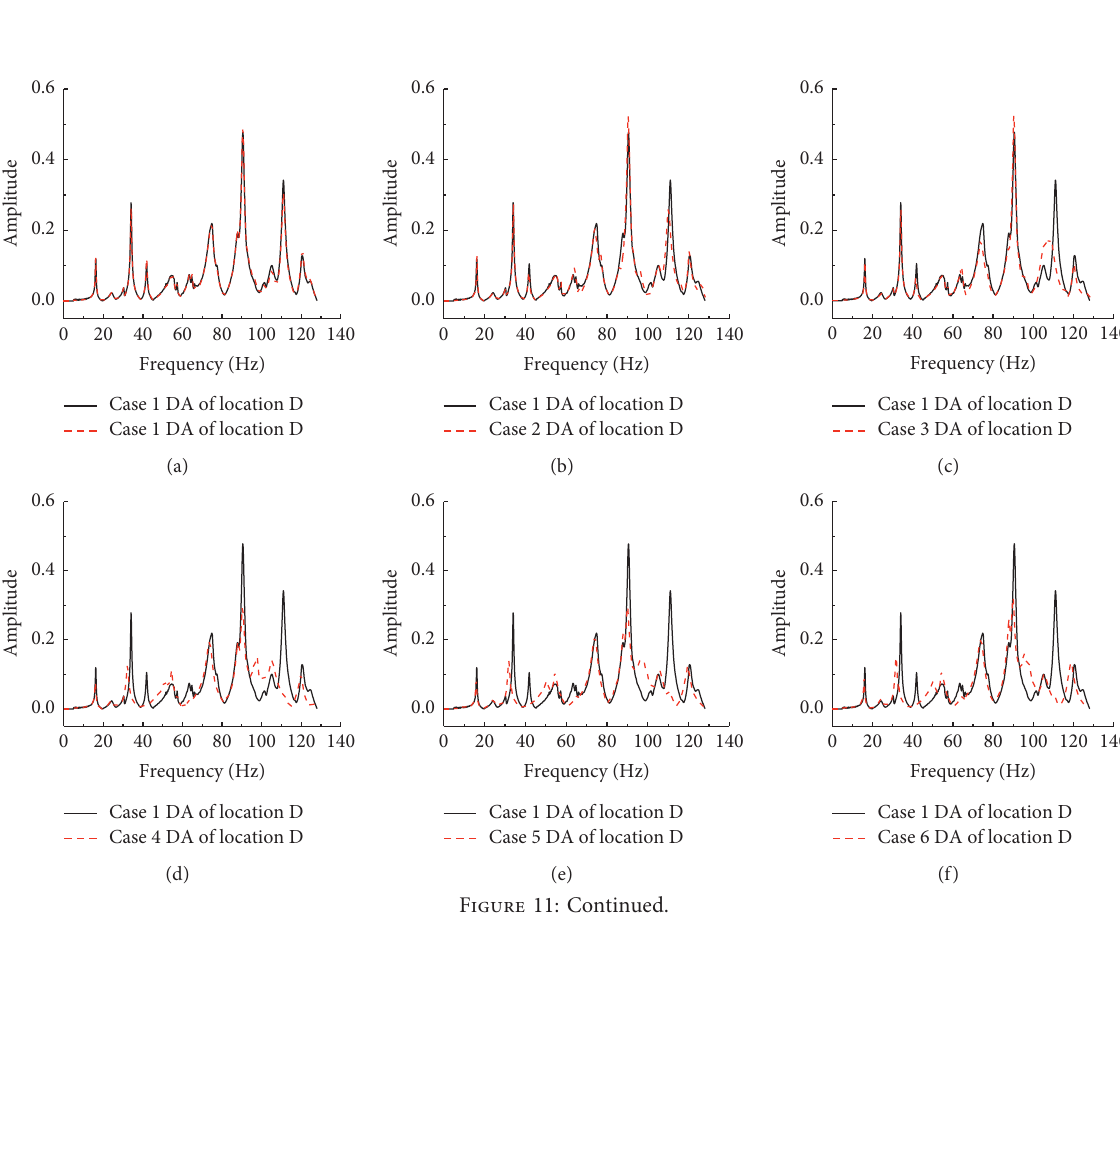
Figure 10: Comparison of DA of driving point A under different cases, (a) 1 vs.1; (b) 1 vs. 2; (c) 1 vs. 3; (d) 1 vs. 4; (e) 1 vs. 5; (f) 1 vs. 6; (g) 1 vs. 7; (h) 1 vs. 8; (i) 1 vs.